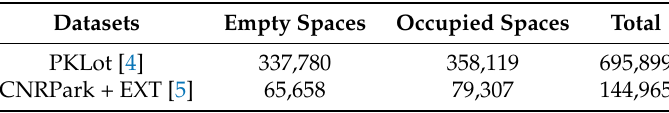
Table 1. Number of images in the